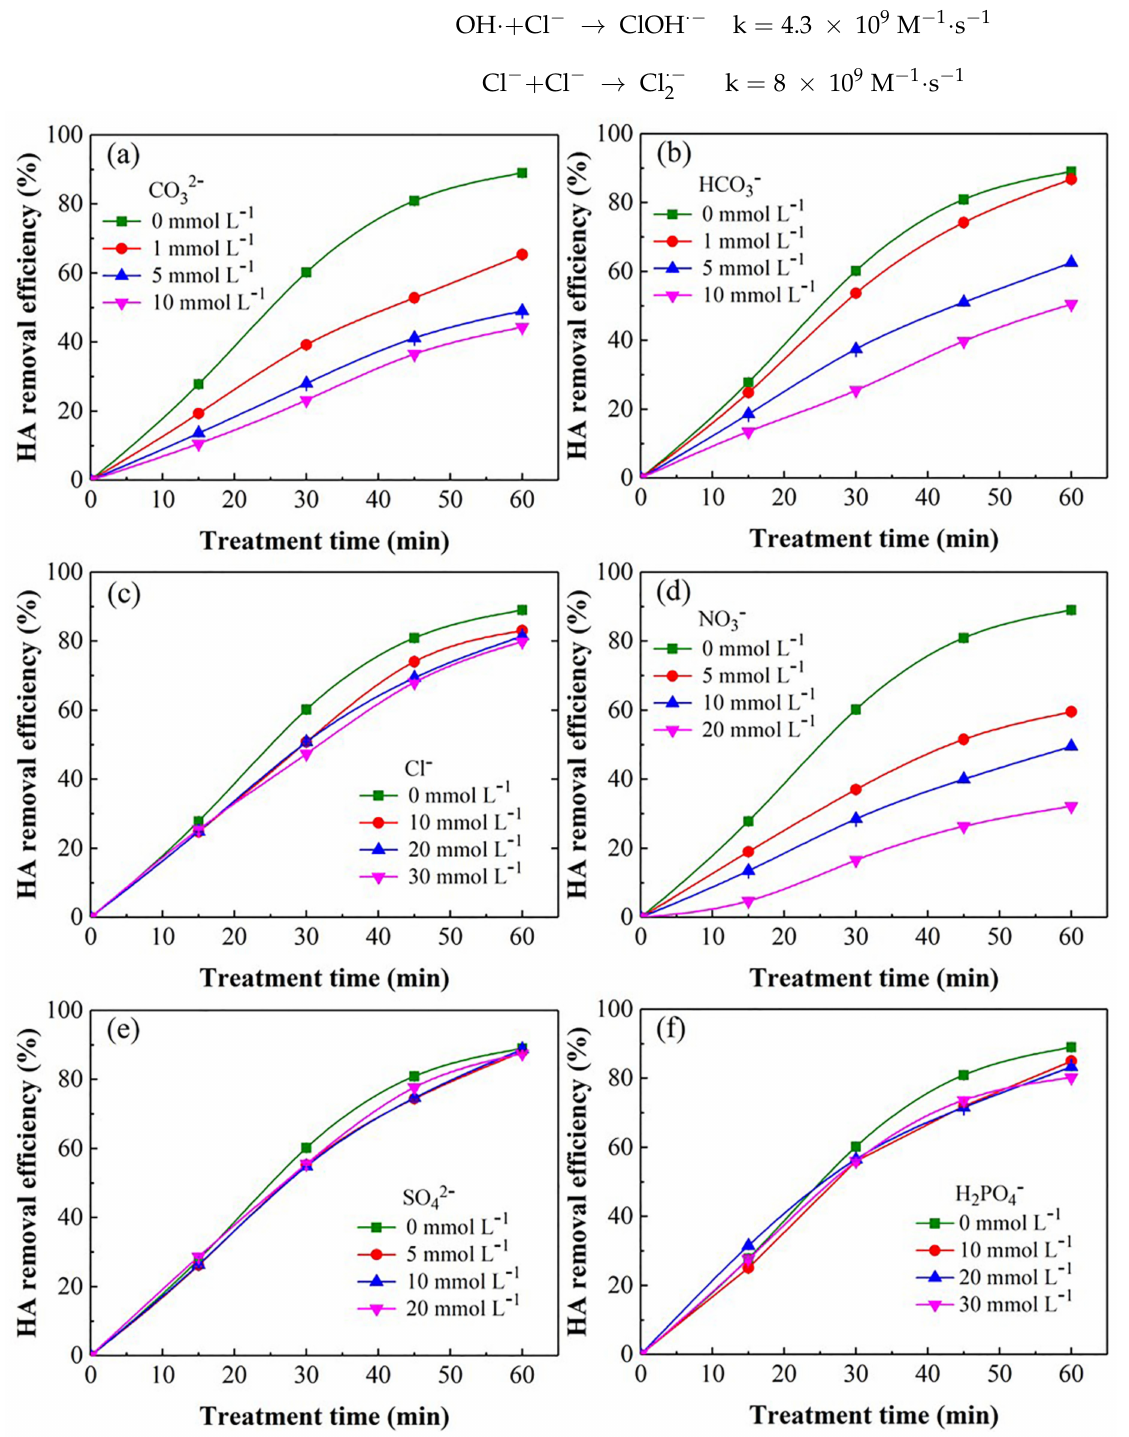
Figure 3. Effect of common anions on HA elimination in UV/SPB: ( a ) CO 3 2 − , ( b ) HCO 3 − , ( c ) Cl − , ( d ) NO 3 − , ( e ) SO 4 2 − , ( f ) H 2 PO 4 − . ([HA] 0 = 10 mg L − 1 , [SPB] 0 = 1 mmol L − 1 , pH =